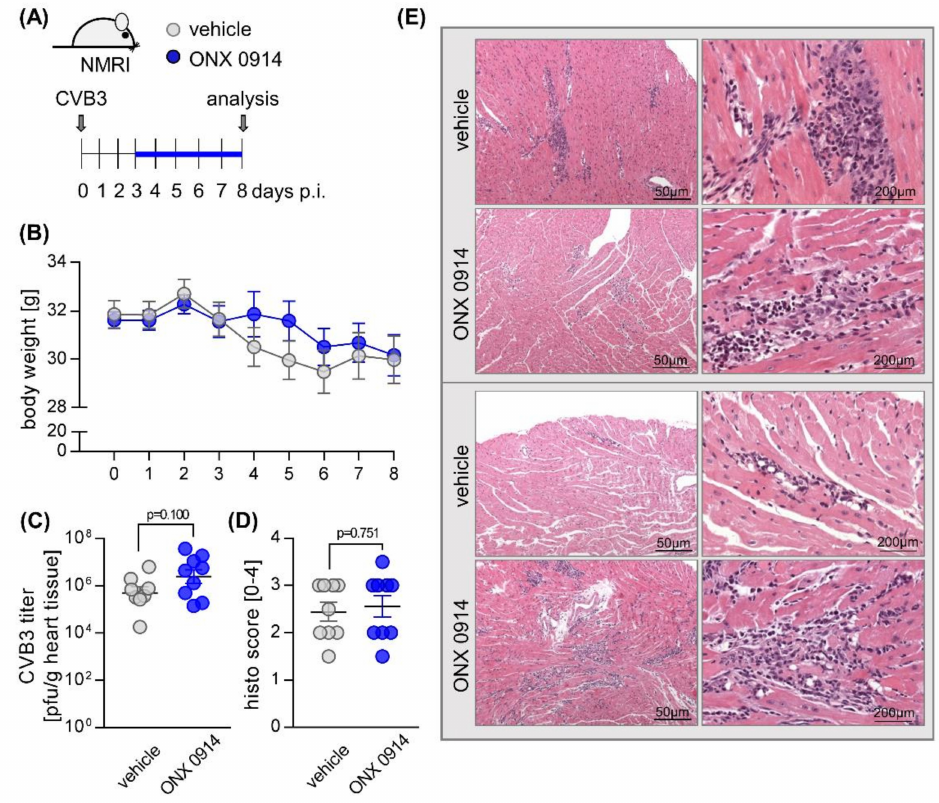
Figure 2. E ff ect of ONX 0914 on the manifestation of acute viral myocarditis in NMRI mice. ( A ) Mice were infected with 5 × 10 5 pfu CVB3 strain 31-1-93 (day 0). From day 3, mice received either ONX 0914 or vehicle daily until day 8. ( B ) Body weight was monitored as indicated. ( C ) Viral titers in hearts of both vehicle and ONX 0914-treated mice were determined by plaque assay. ( D ) Mice were then sacrificed, and heart tissue was analyzed microscopically for inflammation and fibrosis. ( E ) Histological images of two representative animals per group are shown. Data are summarized as mean ± SEM. Body weight was analyzed using two-way ANOVA, all remaining data were analyzed by unpaired t